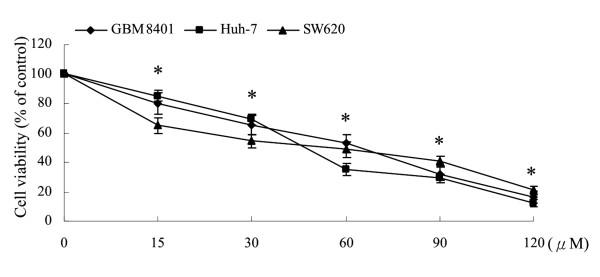
Inhibition of cancer cell growth by squamocin. GBM8401, Huh-7, and SW620 cells were treated with the indicated concentrations of squamocin, and cell viability was determined by an MTT assay. Data are the mean of three independent experiments. * p < 0.05, compared to the control.